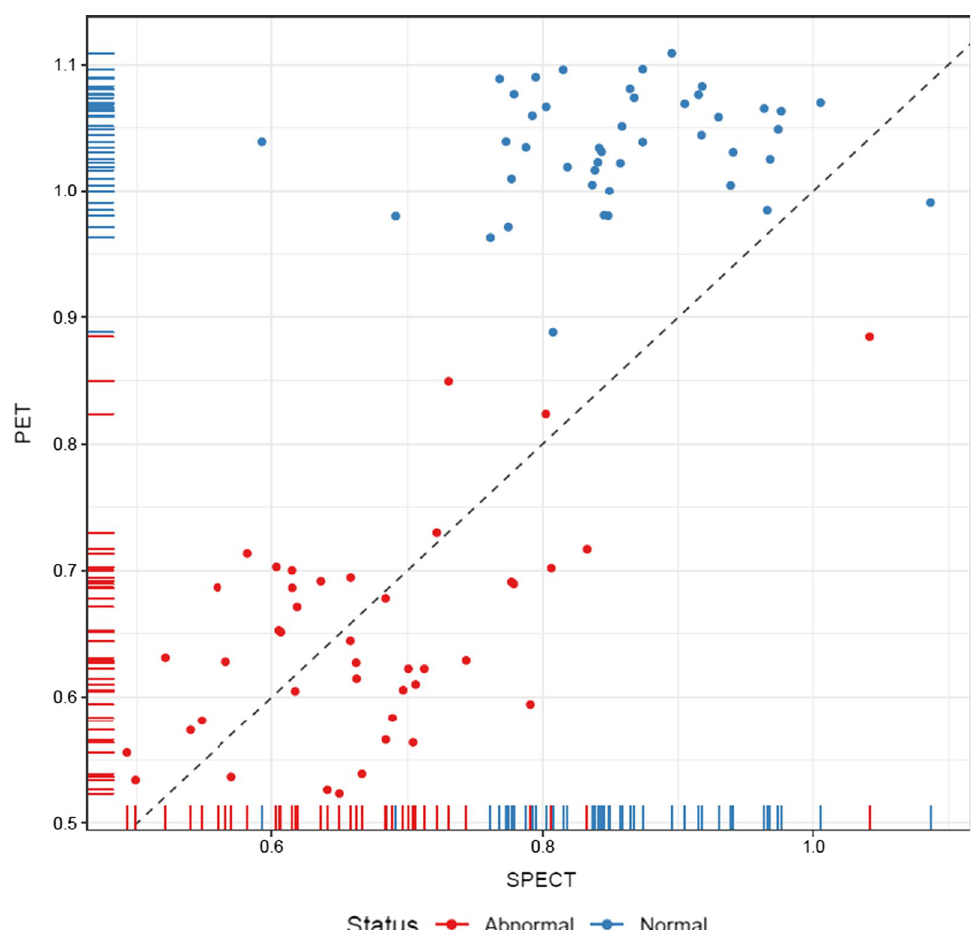
Fig. 5 PET versus SPECT. The lowest putamen/caudate nucleus ratio of the two hemispheres for each subject, PET plotted against SPECT. The dotted line is the line of identity. Red circles are patients categorized as abnormal while blue are normal. Note that delineation and semiquantitative measure are obtained with different methods for PET and